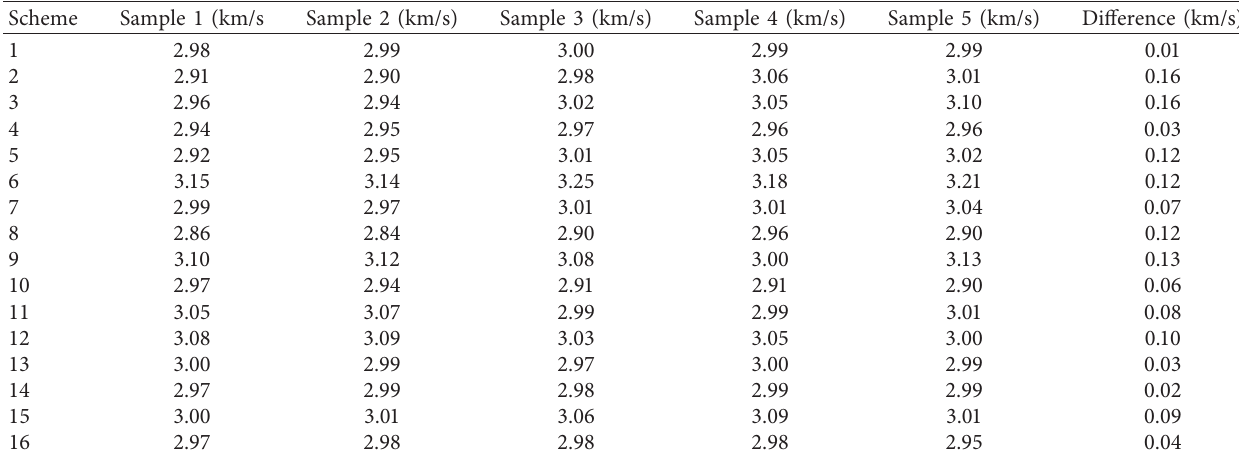
Table 6: Ultrasonic wave velocities of similar material